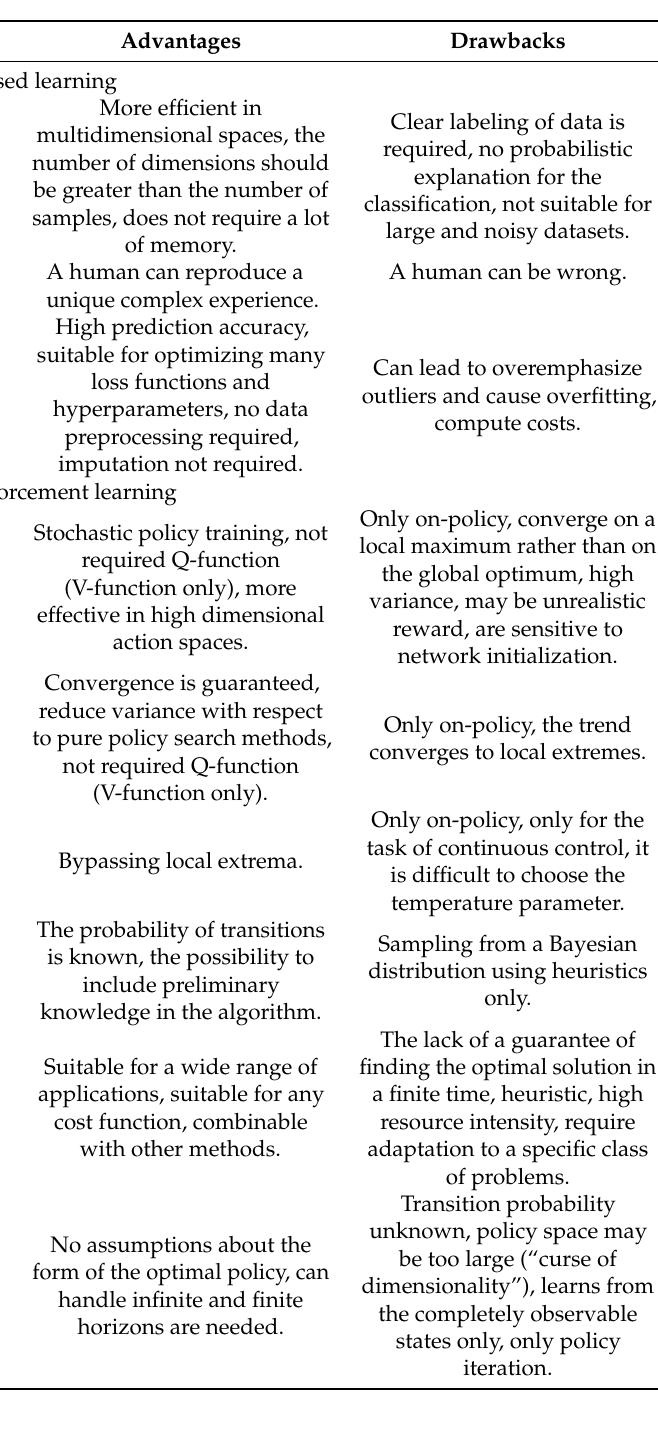
Table 1. Summary table of learning